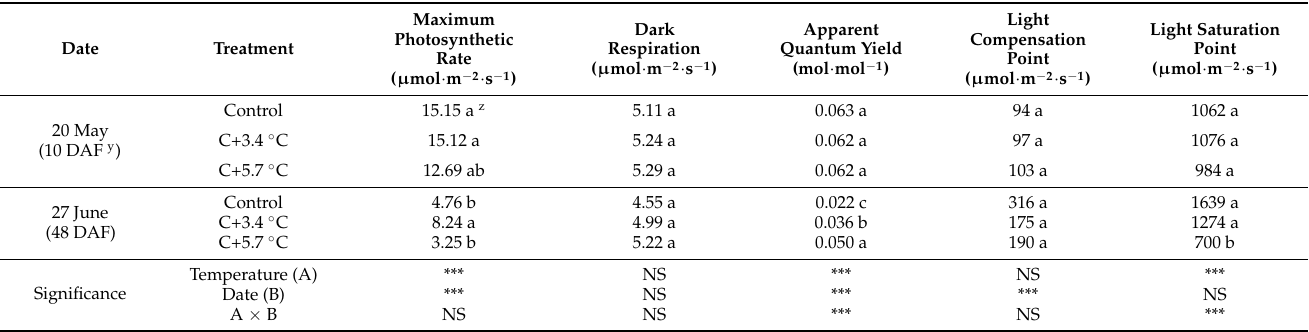
Table 1. Changes in the photosynthetic parameters of ‘Mihong’ peaches affected by elevated temper- ature under a carbon dioxide concentration of 700 µ mol · mol − 1 .